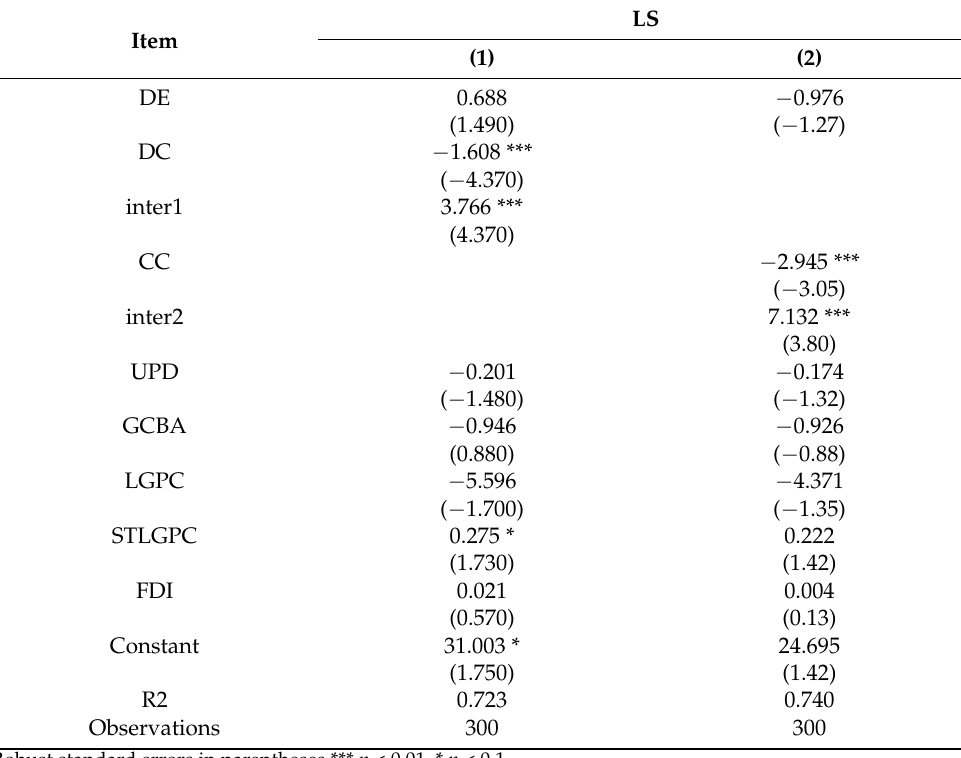
Table 9. Moderating effect test results of digital economy network